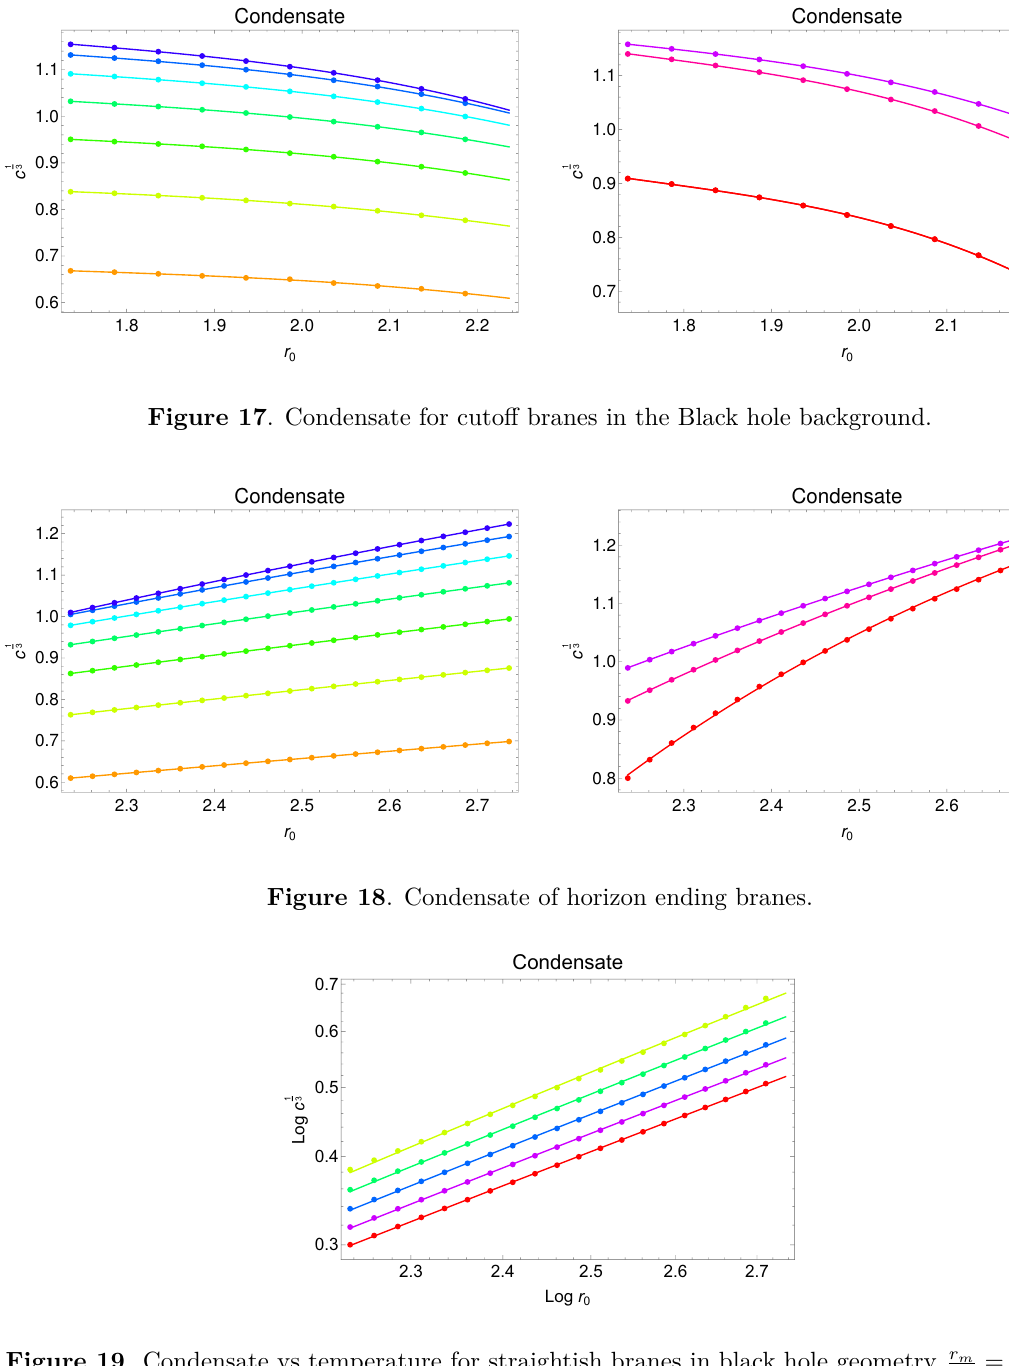
Finally, we plot the condensate as a function of temperature for the straightish branes in the black hole geometry for different values of m in yellow, while the highest value ( m